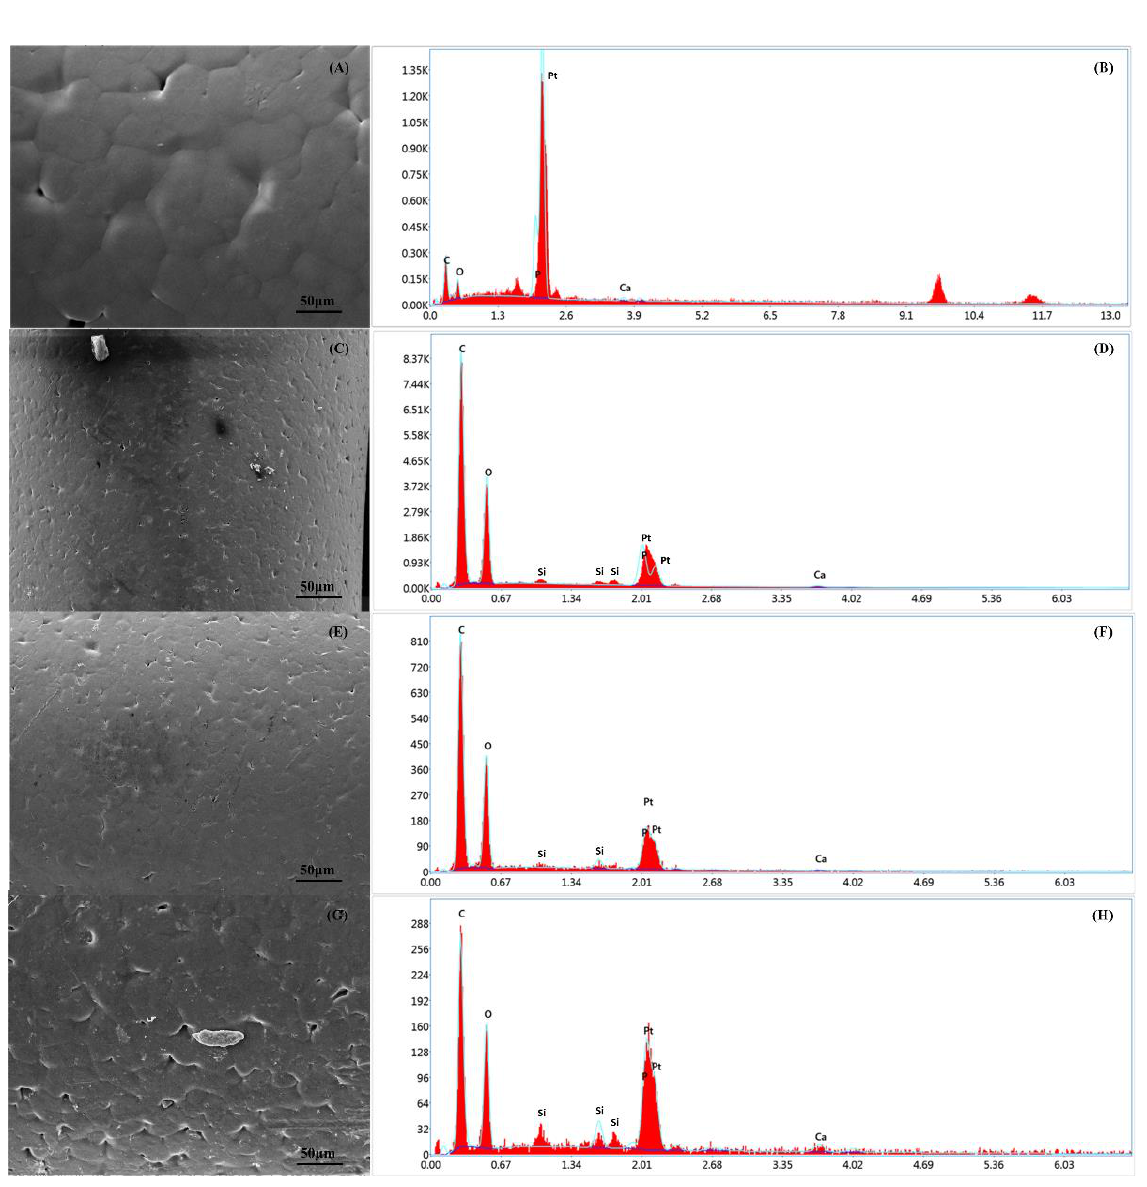
Figure 10. The SEM and EDX spectra of the PCL bone brick ( A , B ); the PCL – bioglass 10 wt% scaffolds ( C , D ); the PCL/HA 15 wt% scaffolds ( E , F ); and the PCL – bioglass 20 wt% scaffolds ( G , H ).